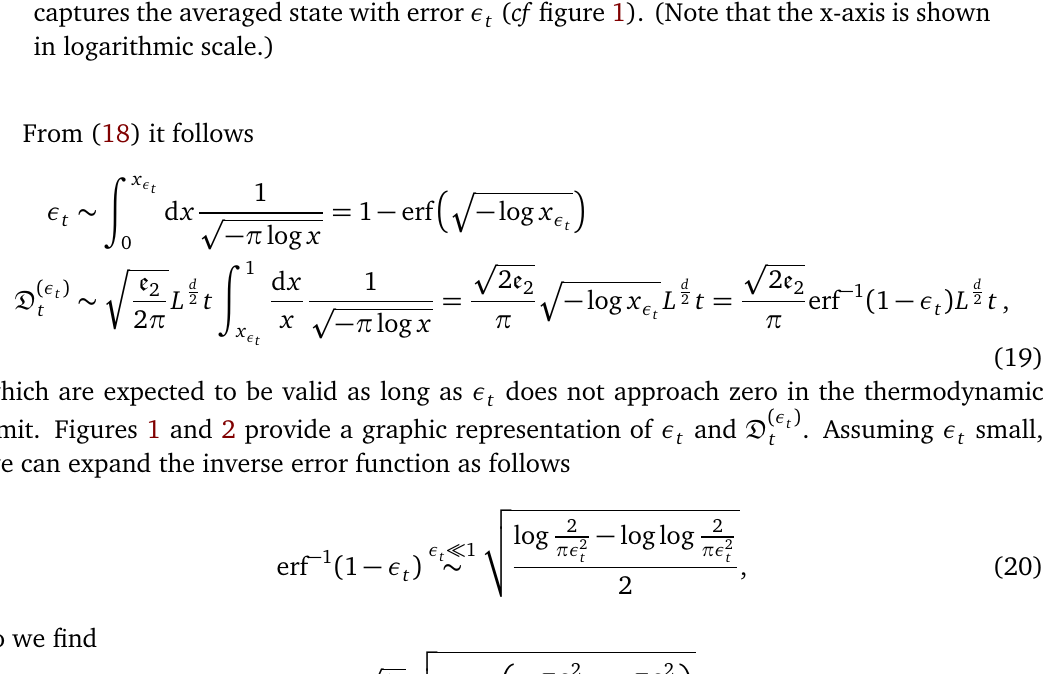
Figure 2: The asymptotic number of eigenvalues larger than λ for a lattice with a large number of sites; Ω = captures the averaged state with error ε in logarithmic